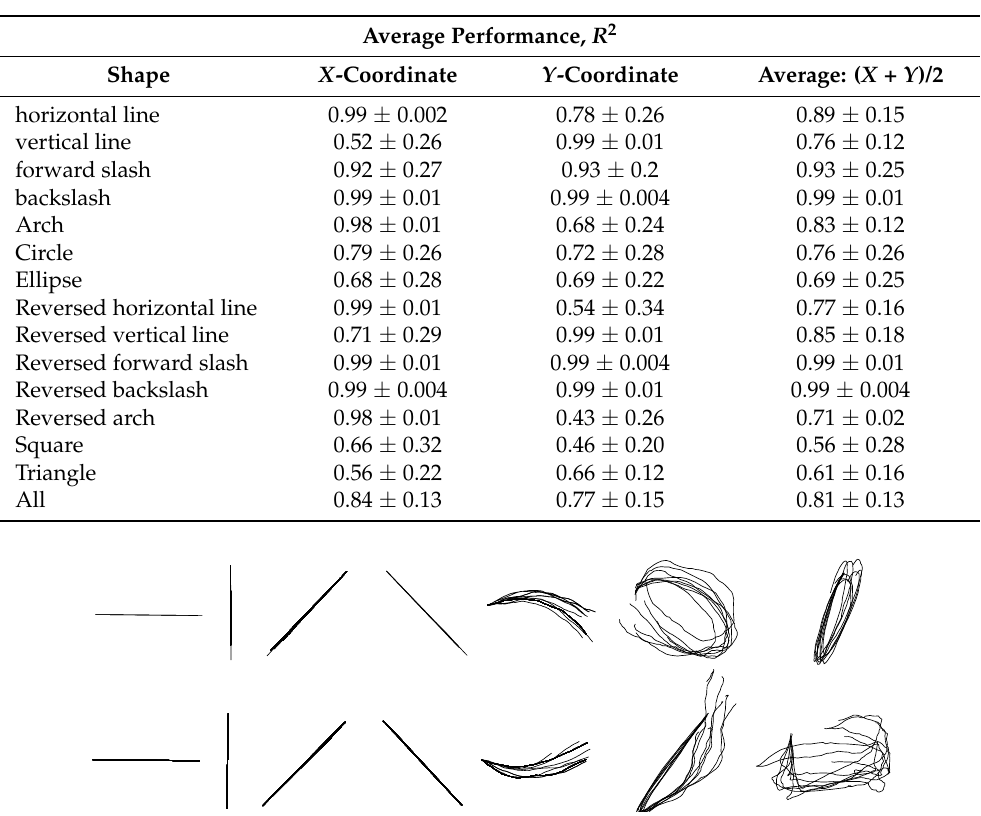
Figure 7. The randomly selected reconstructed drawing traces of between-group reconstruction by the KF-GEP. the